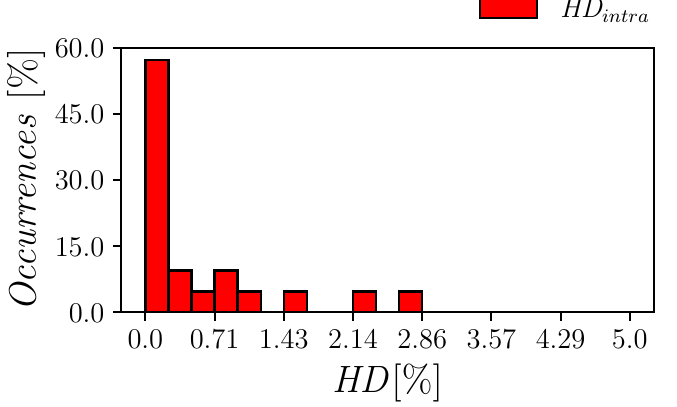
Figure 6. Histogram of the Reliability in terms of HD intra measured over 21 chip samples.